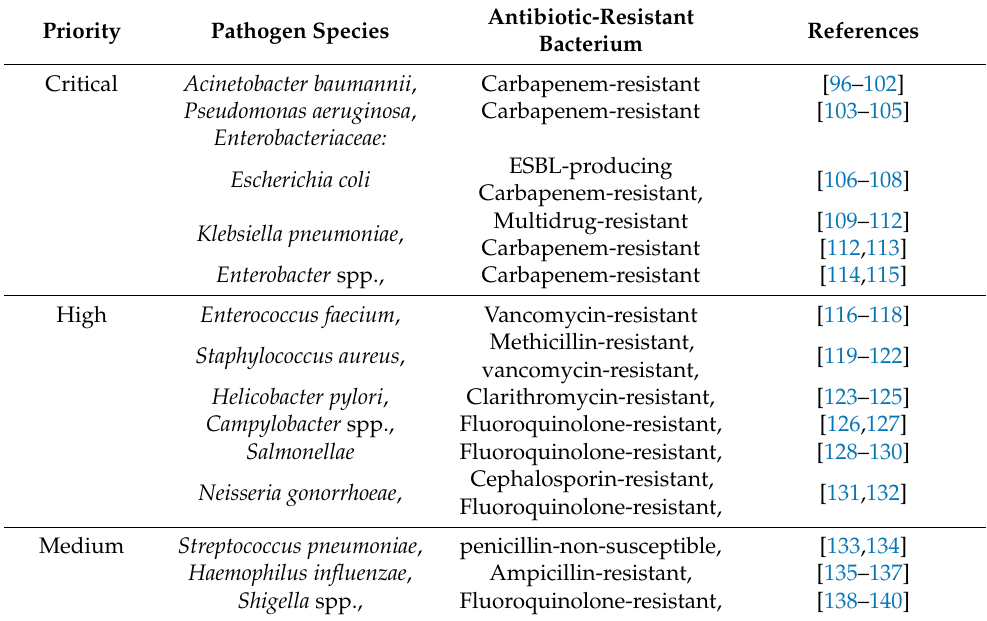
Table 2. List of references of the main applications of phage therapy against multidrug-resistant bacteria classified according to the WHO priorities.